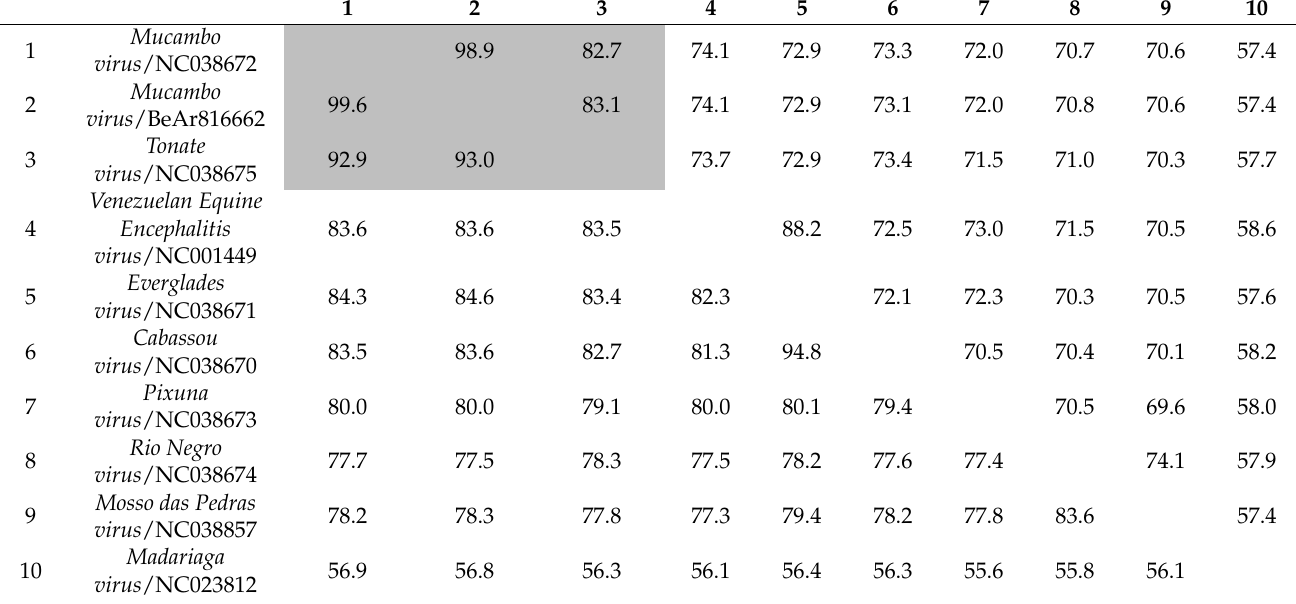
The gray area highlights the highest identity, and values in the top right half of the table show nucleotide identity, and the bottom left half of the table show amino acid identity. The phylogenetic tree of MUCV (BeAr816662), with several other samples from the Al- phavirus family, showed a monophyletic clade inside of the Venezuelan Equine Encephalitis virus complex (Figure 3a). A phylogenetic inference using only MUCV strains revealed three well-defined clades (Figure 3b). The clade 1 isolates comprised the Culex ( Mel .) portesi species from Trinidad and Tobago, obtained in the years 2007 and 1965 [24]. In the clade isolates, samples also showed origins in Trinidad and Tobago but from rodents and sentinel mice, and only two samples were from mosquitoes (TRLV115847 and TRLV62655) obtained in the decade between the 1960s and 1970s. The clade 3 isolates comprised samples isolated in Brazil, identified between the years 1954 and 1969, and within the time of the collected samples from this study, but in an external branch to the group. The non-synonymous mutations in the polyprotein structure showed a correlation with three clades (Figure